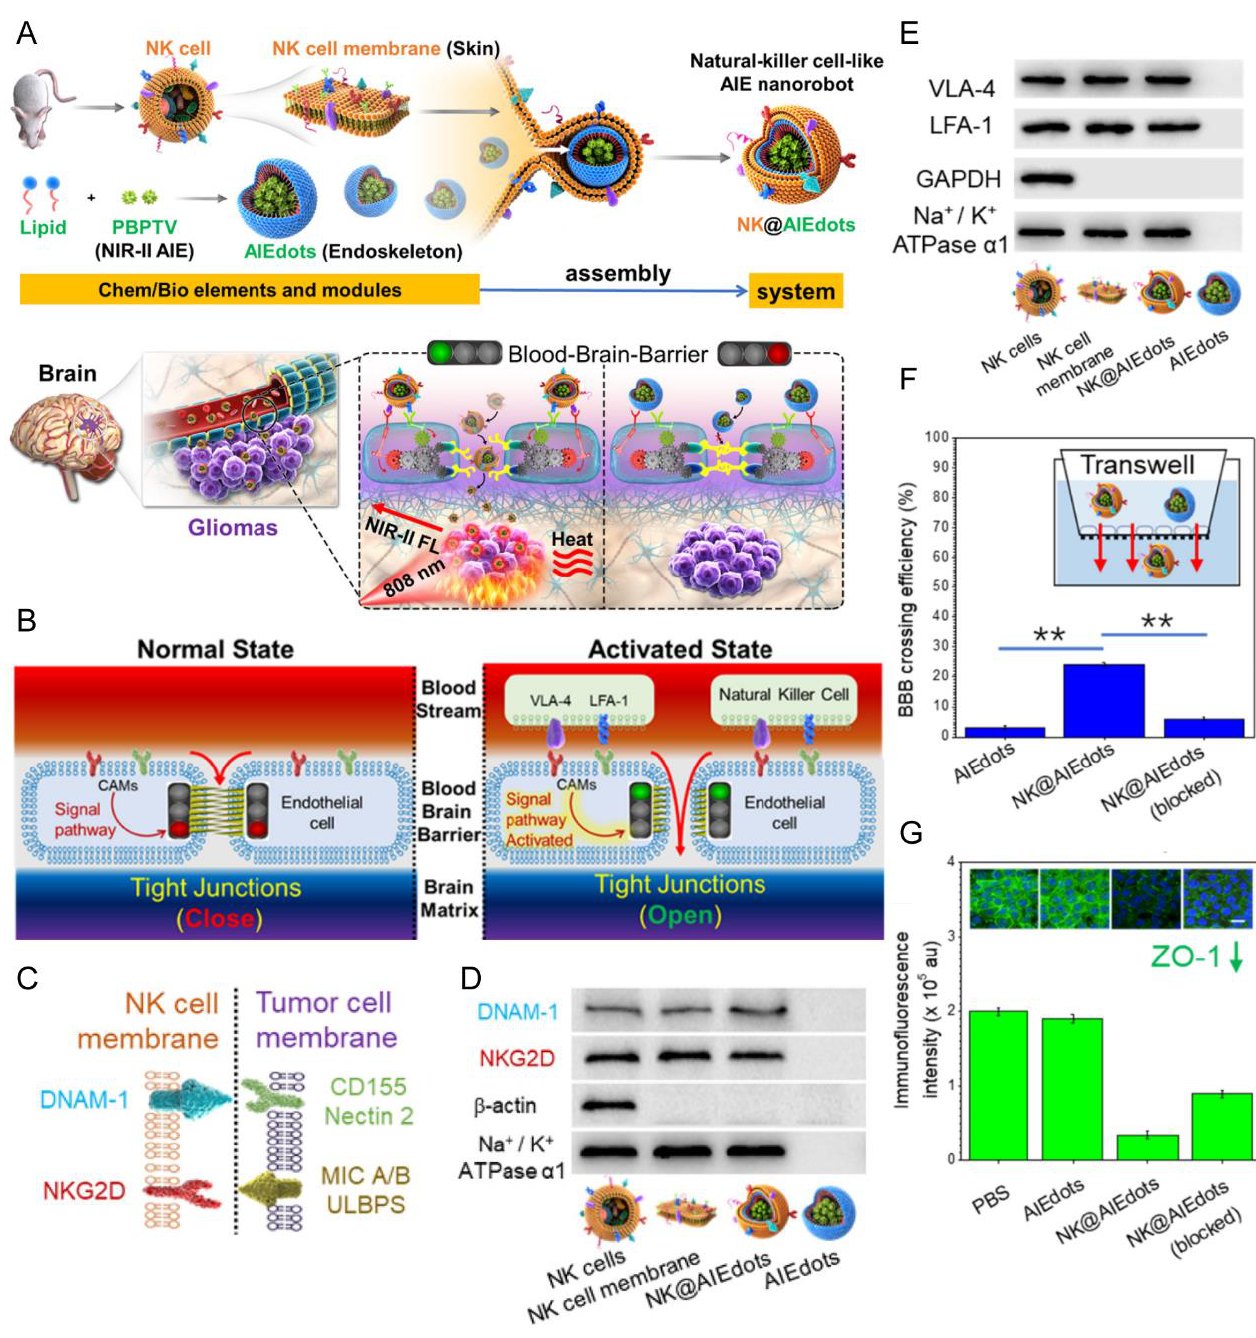
Figure 9. ( A ) Schematic illustration of the synthesis and enhanced BBB penetration of NK cell membrane-coated AIEdots. ( B ) Scheme and principal of NK cell-mediated BBB penetration. ( C ) Scheme of NK cell membrane-mediated brain tumor targeting. ( D )The presence of DNAM-1 and NKG2D on NK@AIEdots. ( E ) The presence of VLA-4 and LFA-1 on NK@AIEdots. ( F ) BBB penetrating efficiency of NK@AIEdots. ( G ) Immunofluorescence staining of TJ-associated ZO-1 after NK@AIEdots treatment. ** p <0.01. NK cell, natural killer cell; AIE, aggregation-induced emission; PBPTV, a NIR-II AIE-active conjugated polymer; CAMs, cell adhesion molecules; DNAM-1, DNAX accessory molecule (CD226); NKG2D, natural killer group 2D; LFA-1, lymphocyte function-associated antigen 1; VLA-4, very late antigen-4; ZO-1, Zonula occludens-1. Reprinted with permission